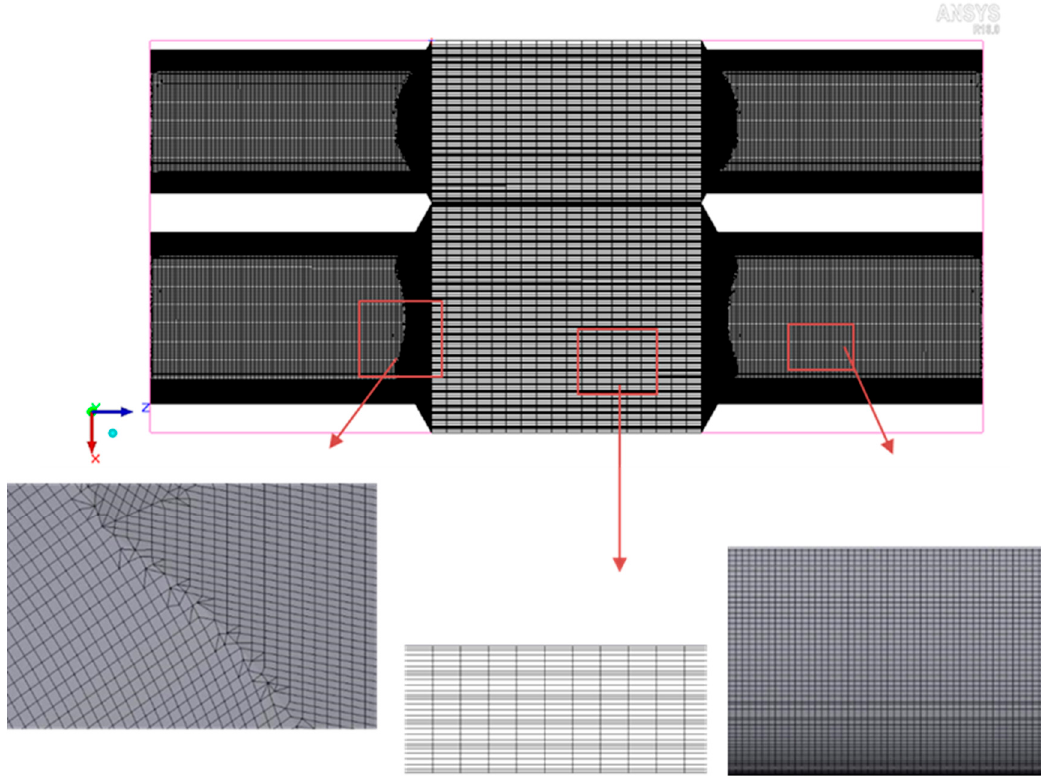
Figure 9. Simulation of discontinuous grid division.